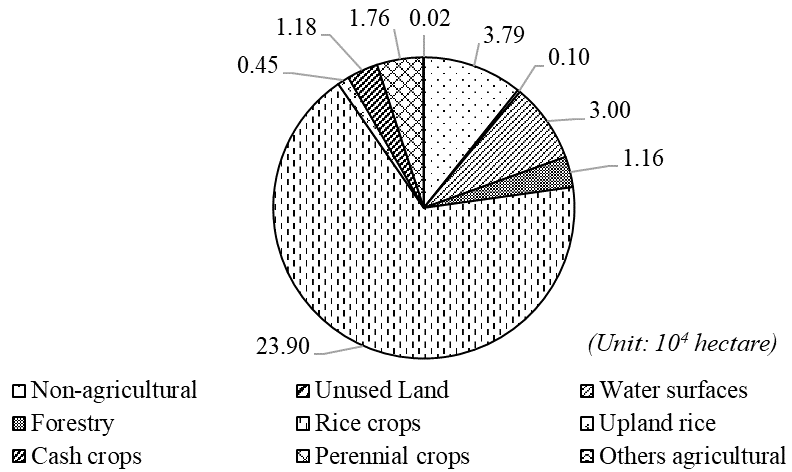
Figure 7. Percentage area of land use types in An Giang province in the year 2020.